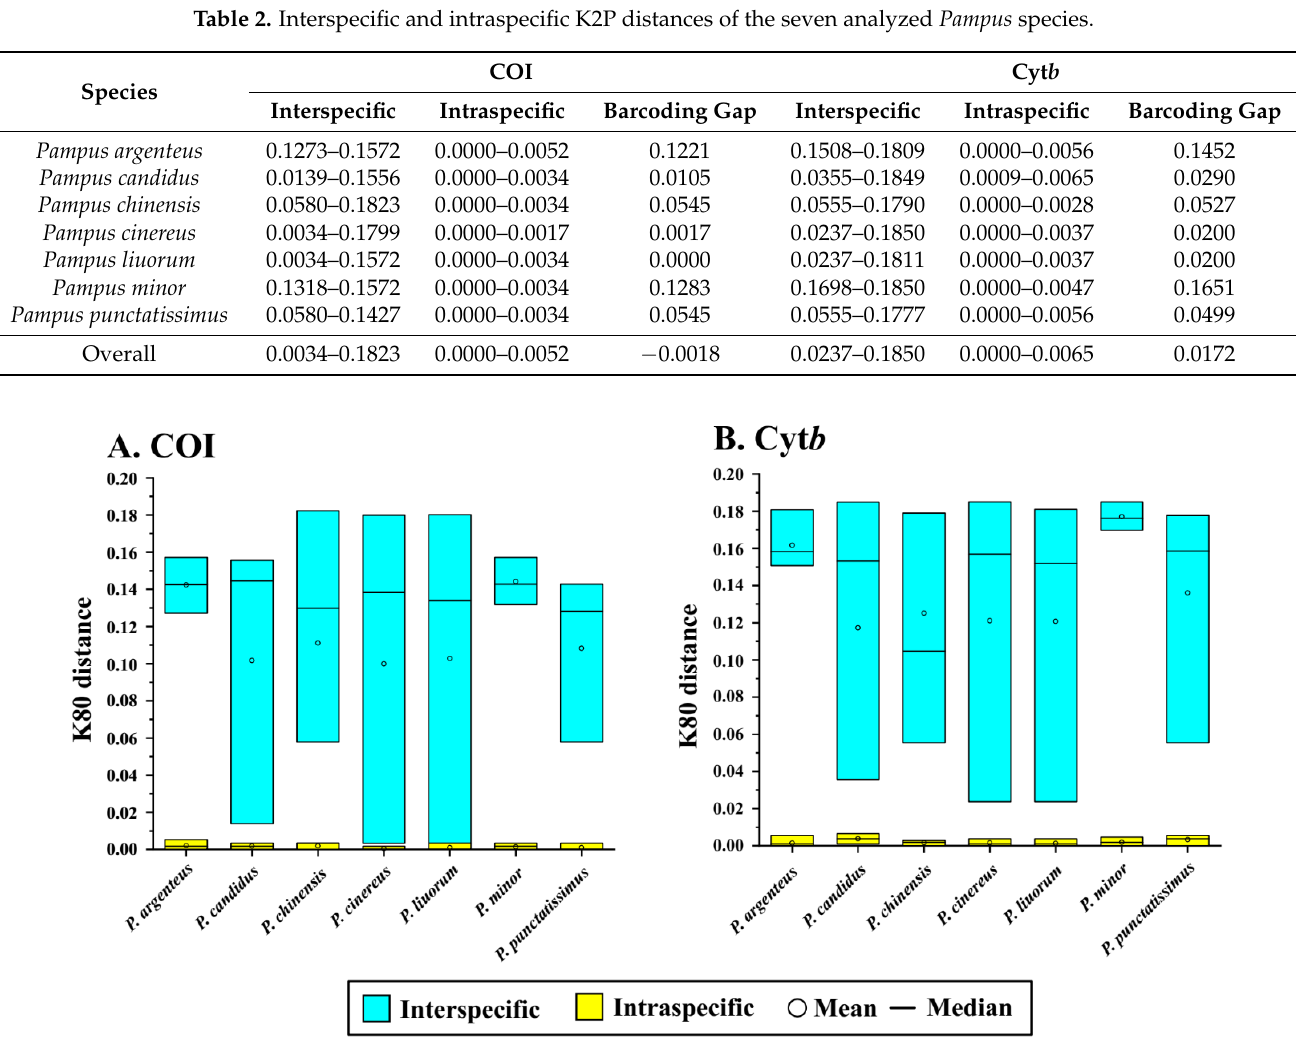
Figure 2. Boxplot showing the COI ( A ) and Cyt b ( B ) barcoding gaps of the studied species in genus Pampus . Pairwise interspecific and intraspecific K2P distances of each species are annotated with blue and yellow. Mean and median values of the interspecific and intraspecific distances are indicated with circles and lines, respectively.